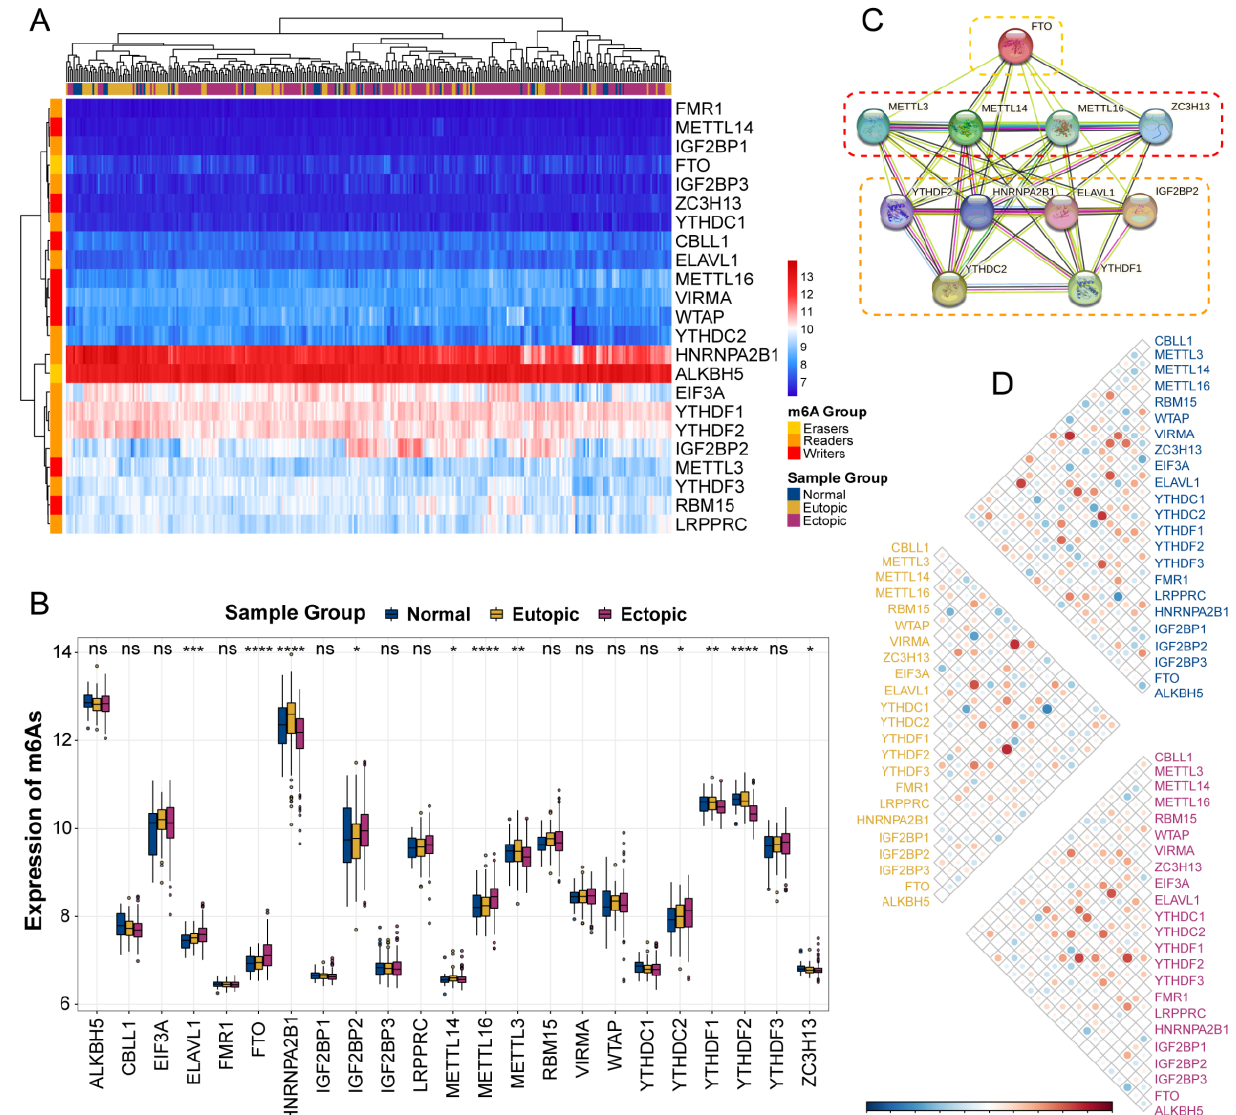
Figure 2. The transcriptome expression status of all m6A regulators between normal, eutopic, and ectopic samples by heatmap ( A ) and boxplot ( B ). ( C ) The protein–protein interactions among differential expressed m6A regulators. Three frames from top to bottom represent erasers, writers, and readers, respectively. ( D ) The correlation analysis of m6A regulators in normal (top), eutopic (median), and ectopic (bottom) groups. ns, p ≥ 0.05; *, p < 0.05; **, p < 0.01; ***, p < 0.001, ****, p < 0.0001.